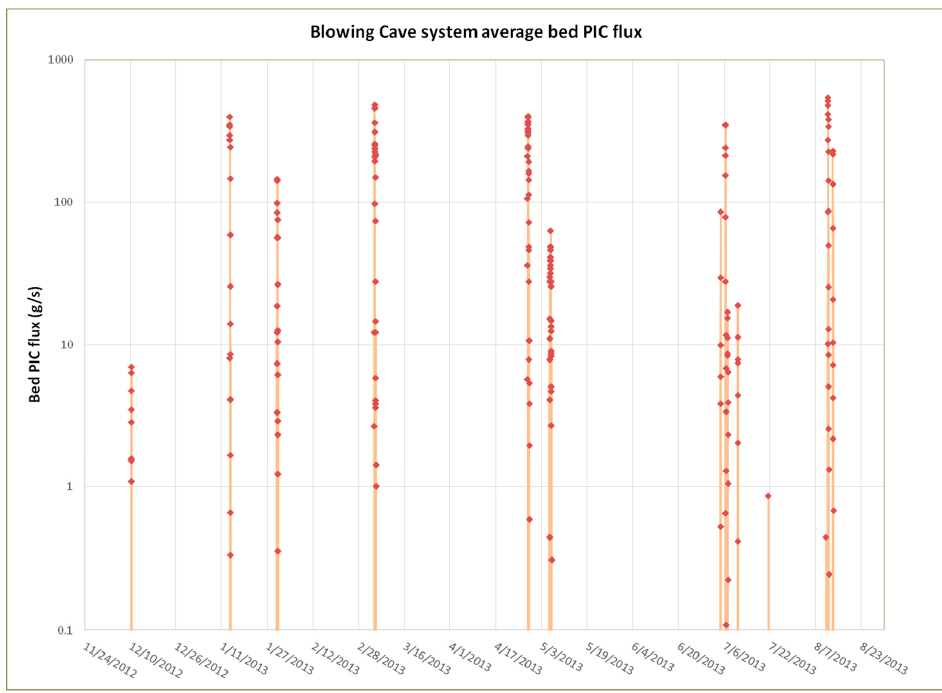
Figure 5. Flux of particulate inorganic carbon carried a bed load through the Blowing Cave Kentucky system. Flux is the average of the three modeled cross-sections representing the main channel types in the system using the constant 0.075 for XS-1 and XS-3, and 0.043 for XS-2.